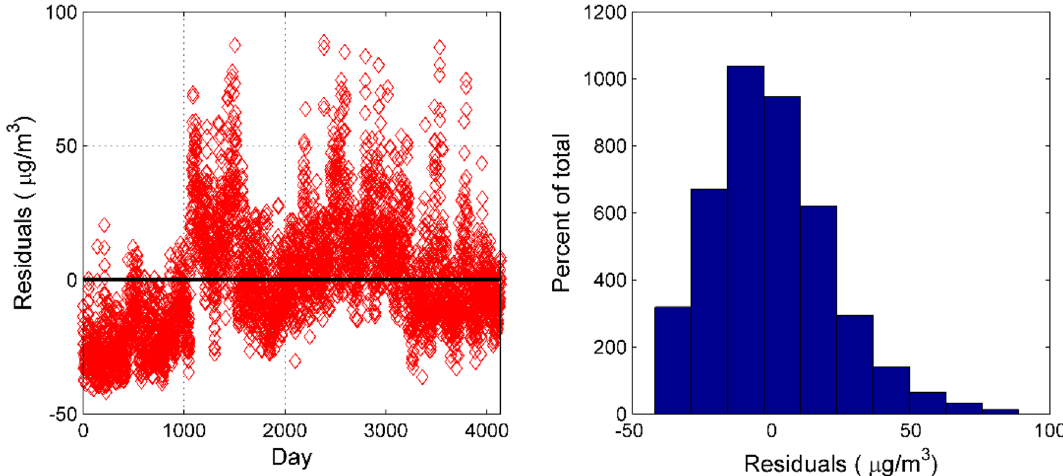
Figure 6. Residual test of PCR model. The residuals vs. day plot is seen on the left. The histogram of the residuals is seen on the right.